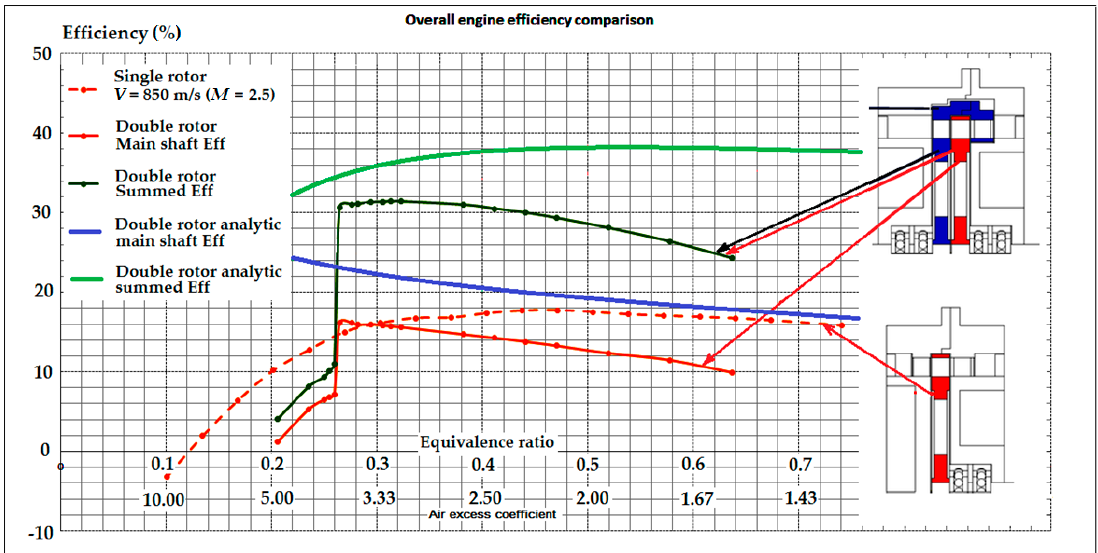
Figure 24. Theoretical overall engine efficiency and efficiency of engine components compared with the efficiency obtained via numerical